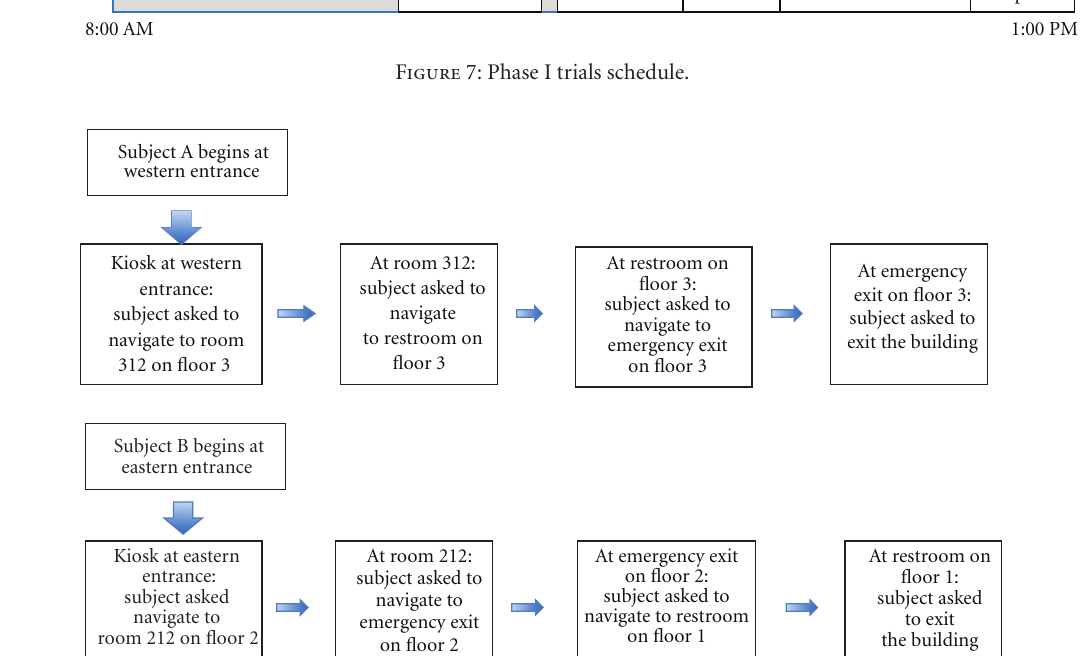
Figure 8: Test scenarios in Phase I